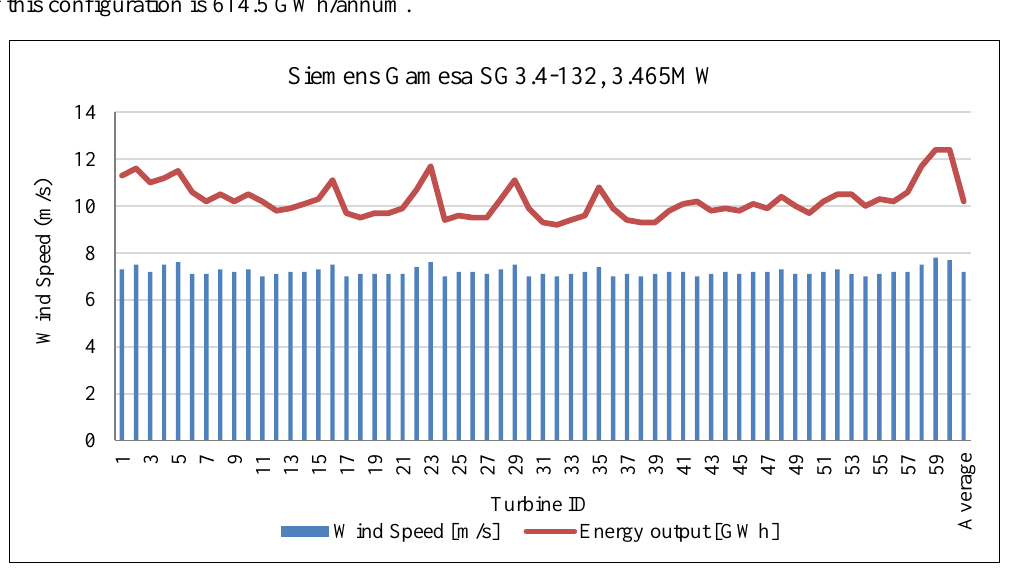
Figure 4. Energy results for configuration 1, Siemens Gamesa SG3.4-132, 3.465MW  Configuration 2, Vestas V126-3.45 HTq: In this configuration, the hubs of the turbines are installed at the elevation of 87 meters. The total energy output of this configuration is 551.9 GWh/annum.